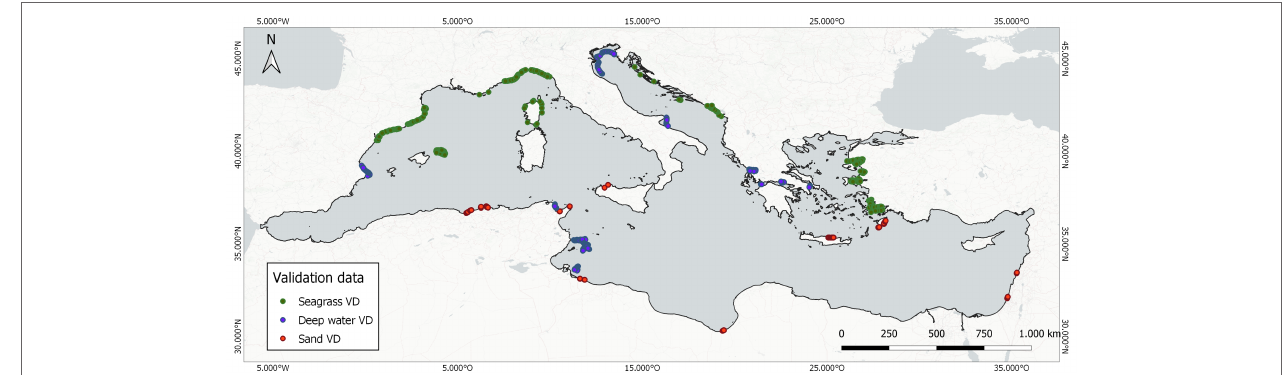
FIGURE 4 | Distribution of the employed 2,480 validation data